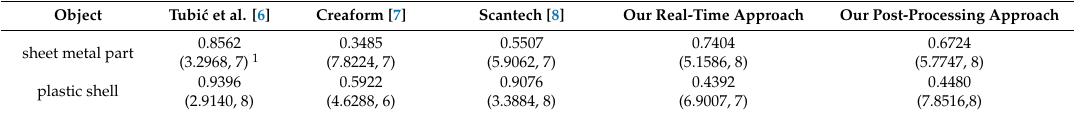
Table 5. Pearson’s χ 2 test for samples of di ff erent methods.